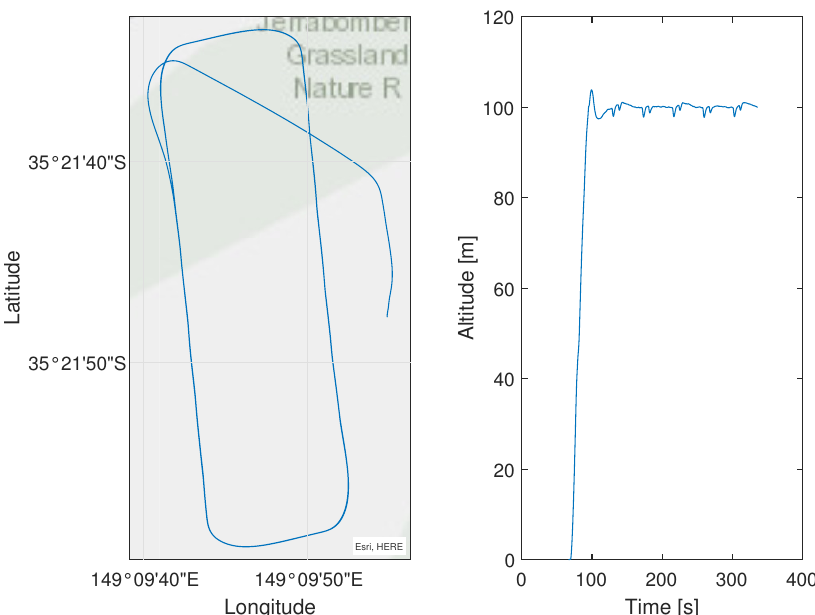
Figure 11. SITL: Horizontal path of the UAV ( left ) and altitude in meters above home position ( right ).